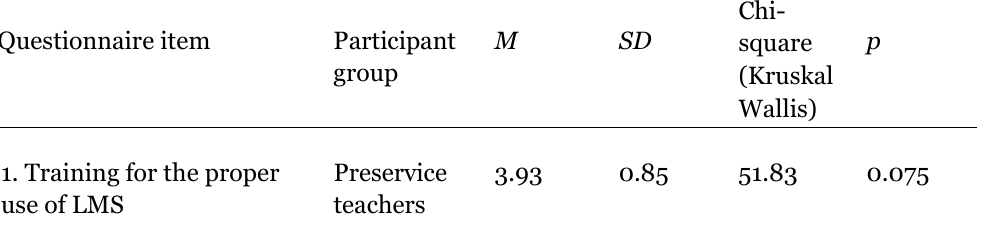
Questionnaire Results on the Training Needs of Preservice Teachers and University Instructors